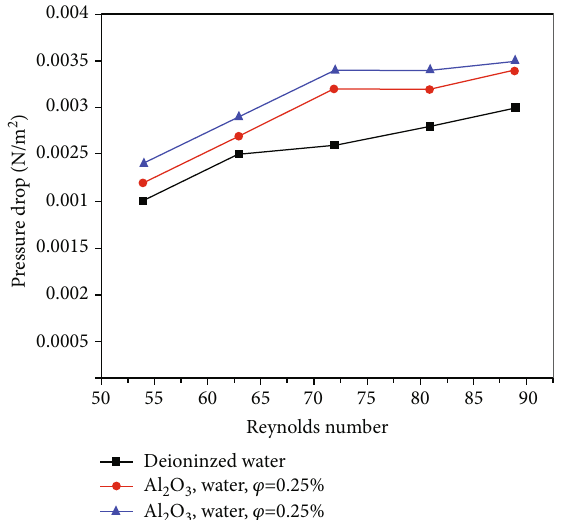
Figure 11: Pressure drop vs. Reynolds number 15W with heat